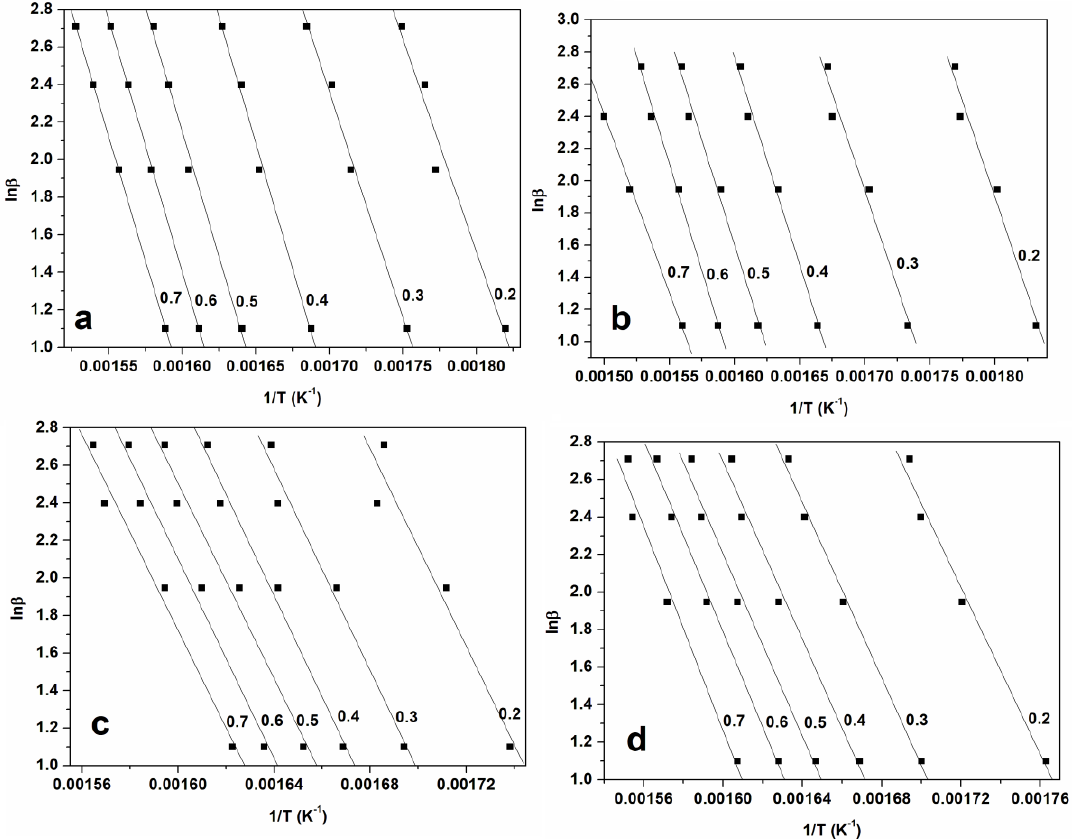
Figure 5. ( a ) FWO of untreated SCB; ( b ) FWO of untreated SW; ( c ) FWO of SBC cellulose; ( d ) FWO of SW cellulose.